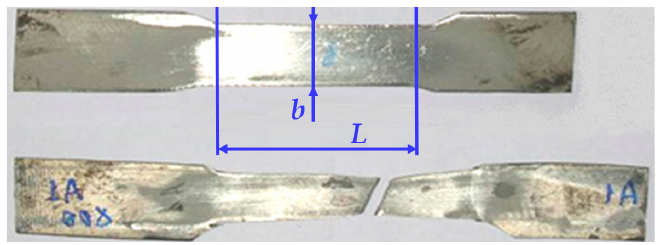
Figure 1. Specimens used to determine the mechanical characteristics of the material.